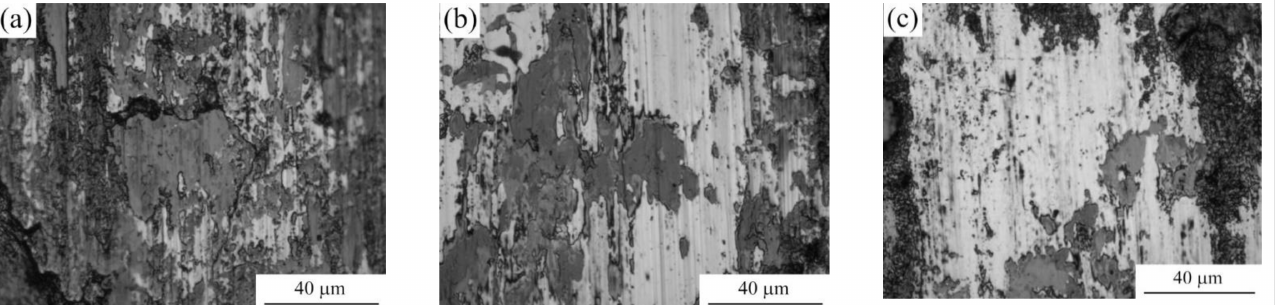
Figure 15. Morphology of the friction tracks on steel surface before treatment ( a ), after PEN ( b ) and subsequent PEP ( c ) in ammonium sulfate (3%) solution at a temperature of 80 ◦ C at a voltage of 300 V under conditions of natural convection of